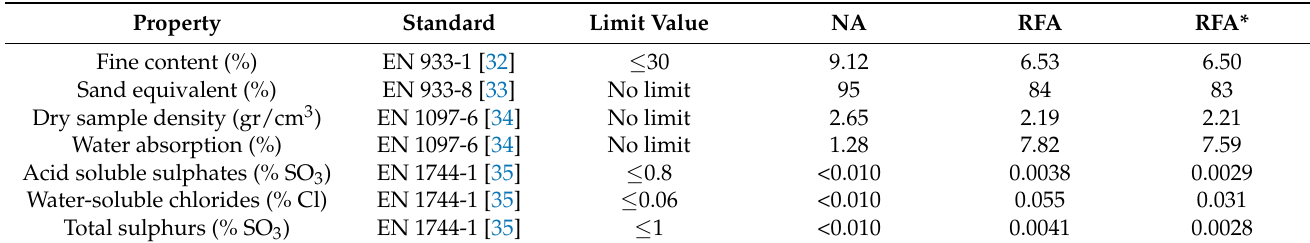
Table 1. Main characteristics of natural aggregate and recycled fine aggregates